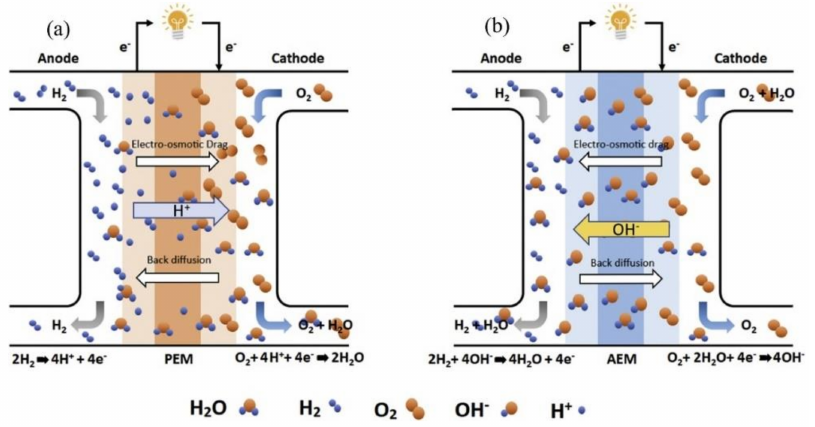
Figure 4. Schematic representation of ( a ) PEMFC and ( b ) AEMFC (Reprinted with permission from ref. [64] Copyright 2020